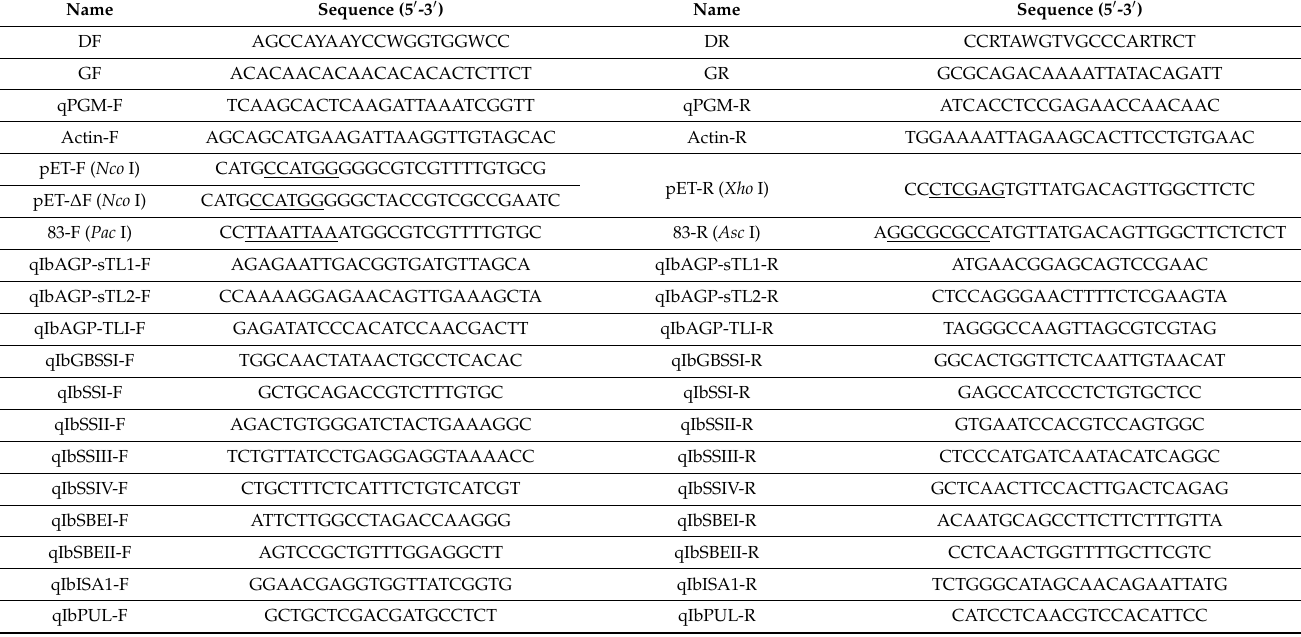
Table 1. Primers used in this